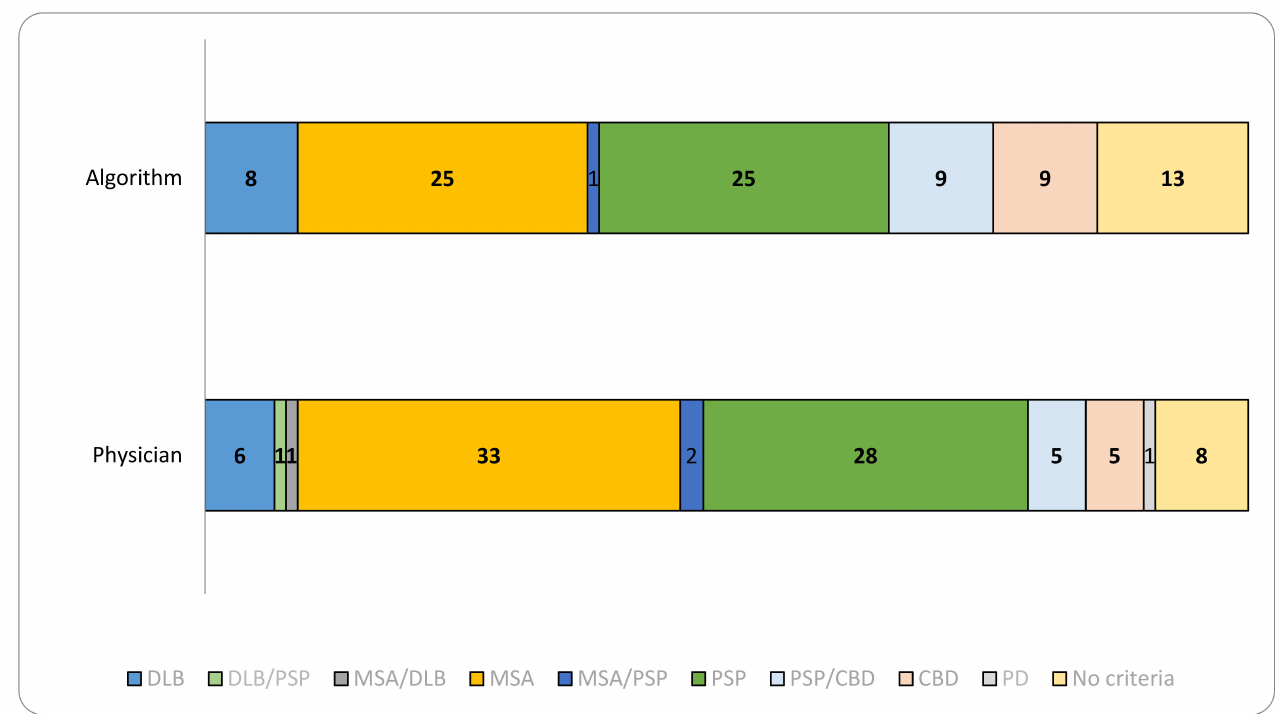
Figure 2. Algorithm versus physician diagnosis of atypical parkinsonian syndromes. Of the 90 diagnoses formulated by treating physicians compared to algorithm-generated results, as many as 50 cases (56% of the total) were clustered as “correct”, 19 as “incomplete” and 21 as “misdiagnosed” as per Figure